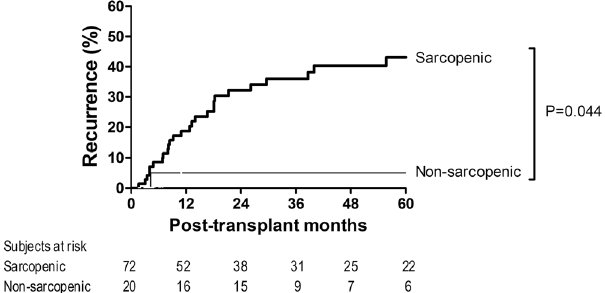
Figure 1. Cumulative recurrence probability according to the presence of sarcopenia. Curves are depicted until 5 years after transplantation because there was no recurrence after 5